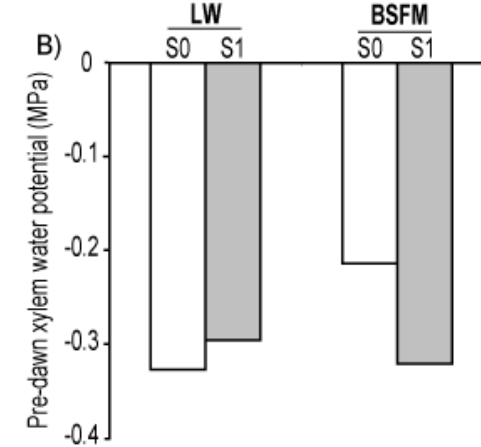
Figure 5. Planting stock size ( A ) and Stand types * Site preparation interaction ( B ) effects on the predawn shoot water potential measured during the first growing season after plantation in black spruce seedlings planted in lichen woodlands and black spruce feather-moss ( n = 32 ( A ), n =16 ( B